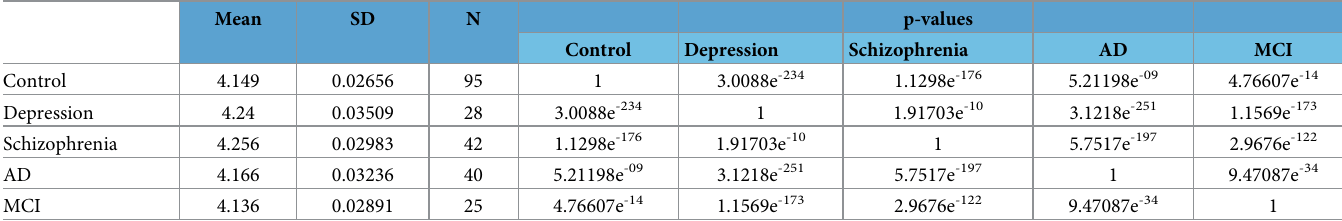
Fig 1. Distribution of p -adic QP values extracted from EEG of neuro-psychiatric patient groups. (A) Cumulative distribution function (CDF) of Qme t,group for control patients (n = 95), patients with depression (n = 28), schizophrenia (n = 42), AD (n = 40), and MCI (n = 25). (B) mean of Qme t,group the for comparison (SEM; control: 4.15 ± 0.03; depression: 4.26 ± 0.03; schizophrenia: 4.24 ± 0.04), AD: 4.14 ± 0.03; MCI:4.17 ± 0.03). (C) Qme t,group significance p-value matrix of pairwise group comparison. (D) cumulative distribution function (CDF) of Qstd t,group of all five patient groups. E, mean of the Qstd t,group (SEM; control: 0.16 ± 0.01; depression: 0.46 ± 0.06; schizophrenia: 0.39 ± 0.05; AD: 0.15 ± 0.02; MCI: 0.16 ± 0.03). F, Qstd t,group significance p-value matrix of pairwise group comparison. https://doi.org/10.1371/journal.pone.0255529.g001 include the Pearson coefficient of correlation, coherence, phase lag, and synchronization likeli- hood [32]. The EEG signal received at each electrode is correlated to the signals at other elec- trodes in space and time. In contrast to this traditional approach, the quantum-like structure Table 2. Mean of quantum potential for participants